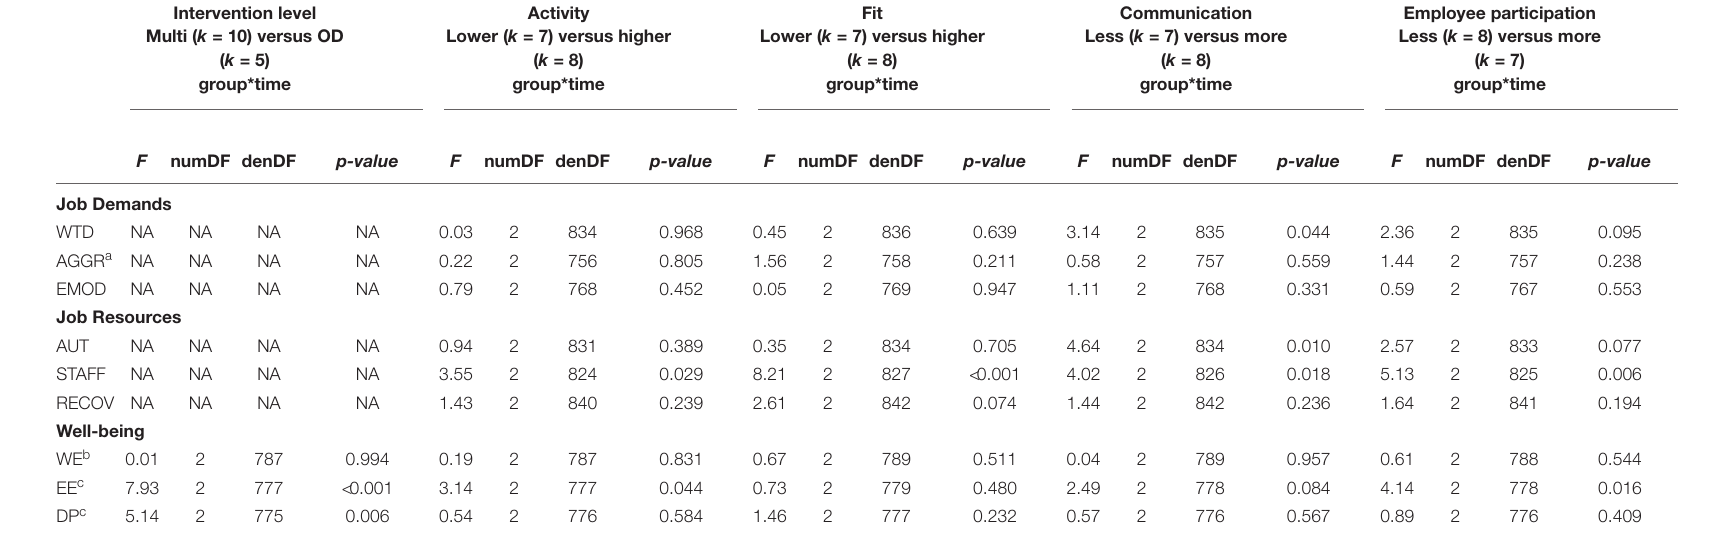
TABLE 2 | Changes over time in job demands, job resources and well-being depending on the intervention level (multilevel or organization-directed), activity (lower versus higher), fit of actions (lower versus higher), communication (less versus more) and employee participation (less versus more) in the intervention project. Intervention level Activity Multi ( k = 10) versus OD Lower ( k = 7) versus